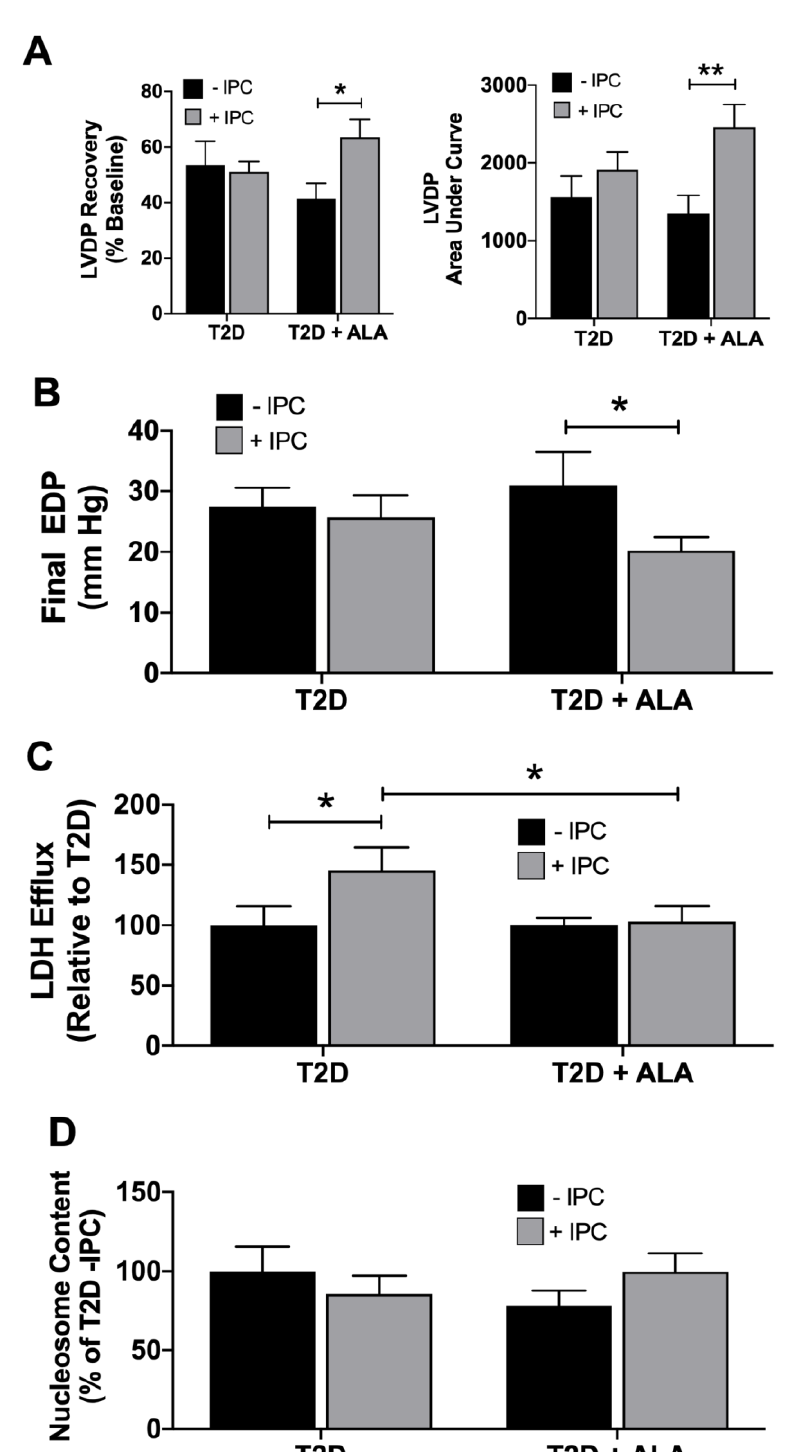
Figure 3. Post-ischemic outcomes in untreated ( − IPC) and preconditioned ( + IPC) hearts from T2D mice ± dietary ALA supplementation. Hearts were subjected to 25 min ischemia / 45 min reperfusion with or without prior IPC (3 × 5 min ischemia / reperfusion). Data are shown for ( A ) final left ventricular developed pressure (LVDP), and LVDP area under the curve throughout reperfusion; ( B ) final end diastolic pressure (EDP); ( C ) total post-ischemic e ffl ux of LDH; and ( D ) post-ischemic nucleosome content. Results presented as means ± SEM (T2D ( − IPC), n = 8; T2D ( + IPC), n = 7; T2D + ALA ( − IPC), n = 8; T2D + ALA ( + IPC), n = 8). *, p < 0.05; and **, p < 0.01.